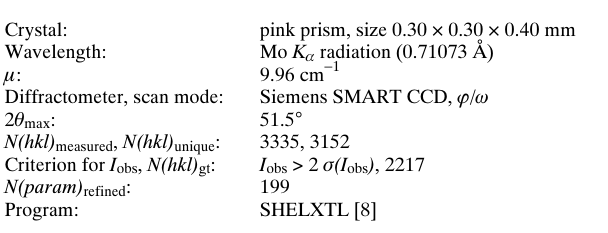
Table 1. Data collection and